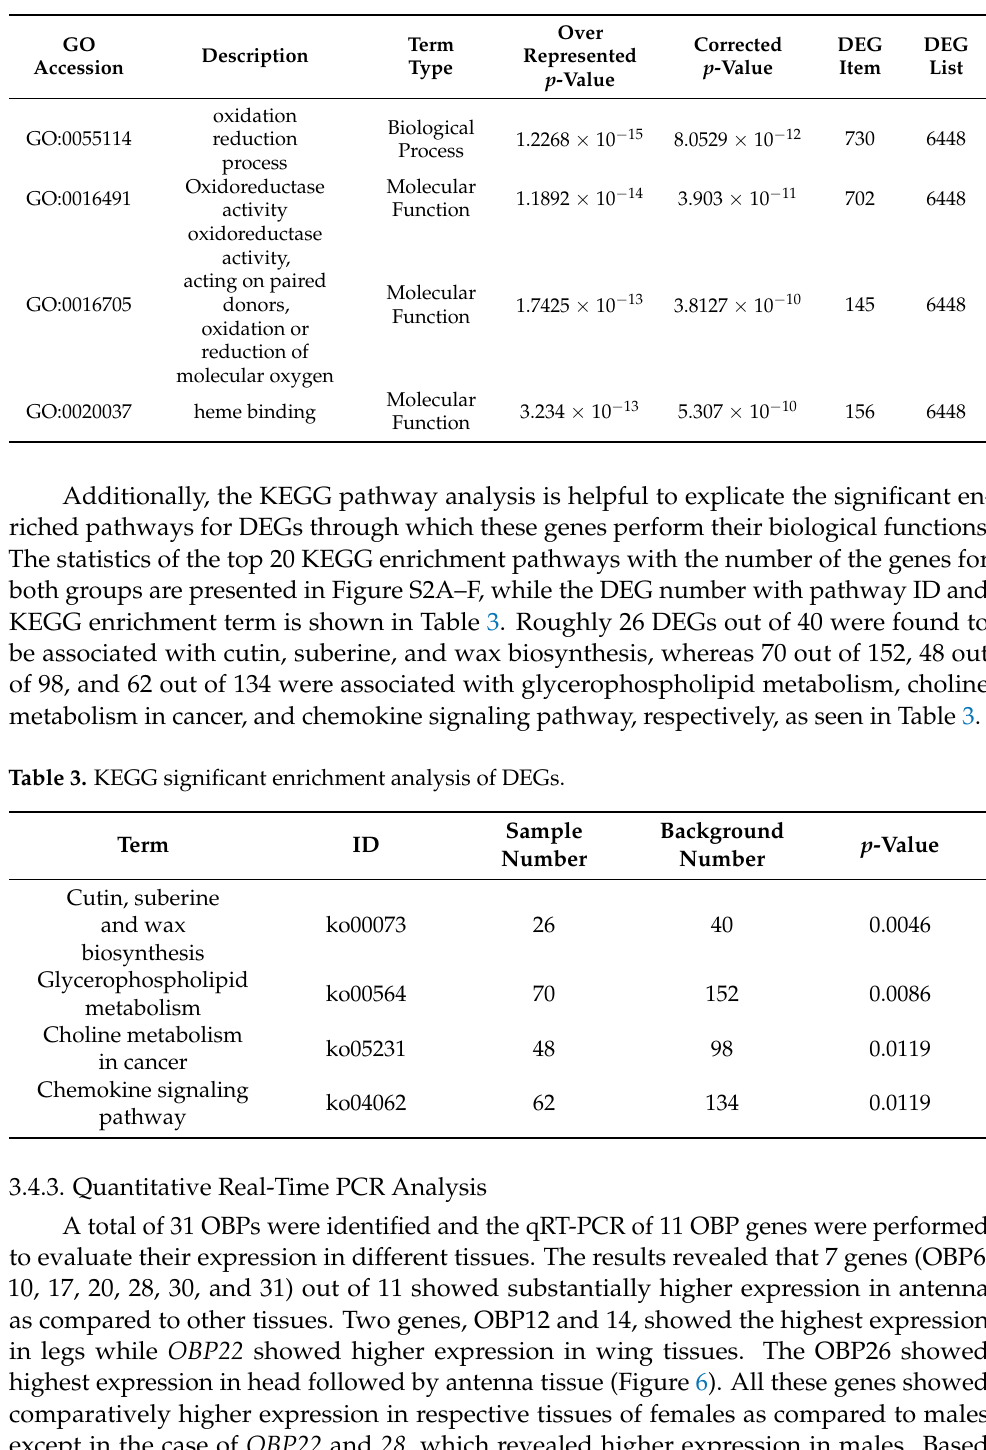
Table 2. The top terms of GO enrichment analysis.